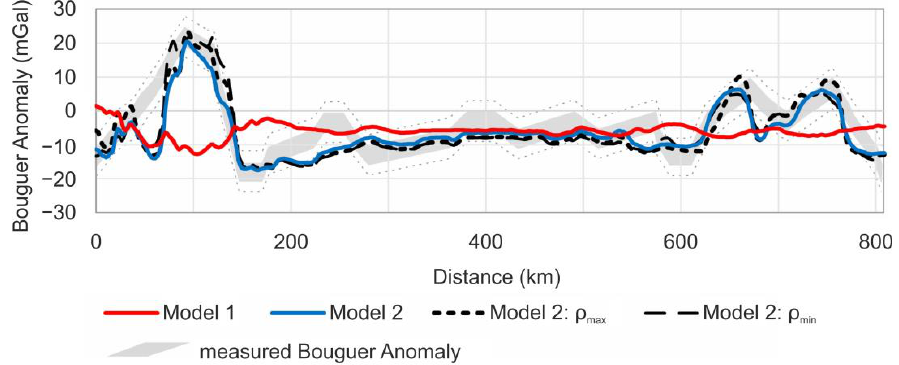
Figure 4. Comparison of Bouguer anomaly observed data digitised from the gravity map [68] (grey stripe) and calculated data for Model 1 (solid red line), Model 2 (solid blue line) and two models of the sensitivity study, Model 2: ρ max (dashed black line) and Model 2: ρ min (solid black line). Dotted grey lines show the ±1.5 mGal interval relative to the observed values.